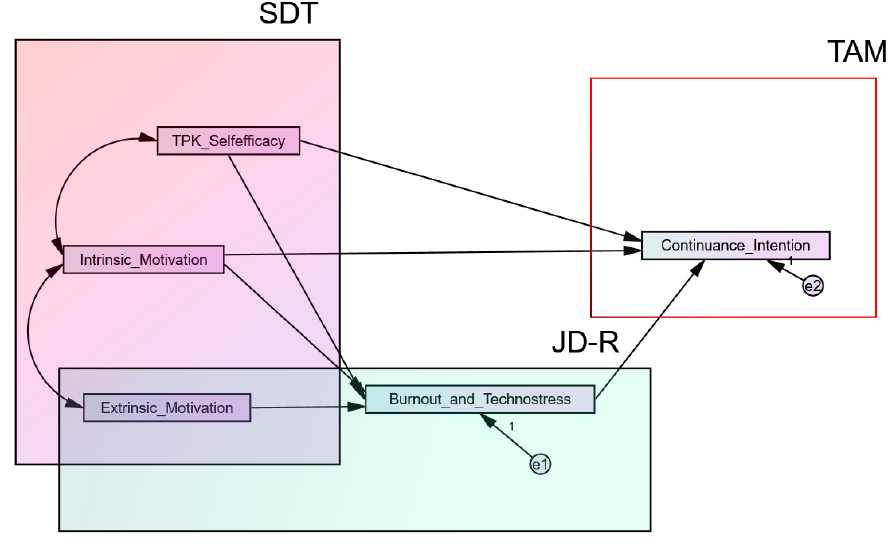
Figure 1. The recommended research model.